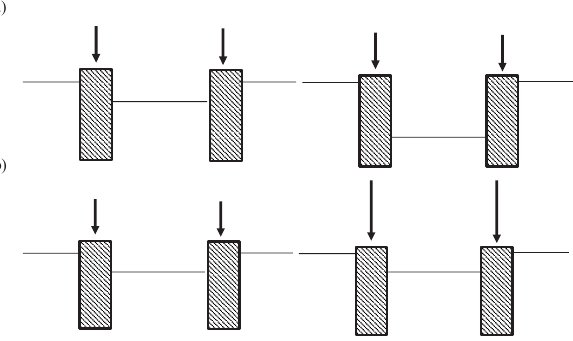
Figure 2: Sources of the foundation load capacity deficiency: a) basement deepening, b) load